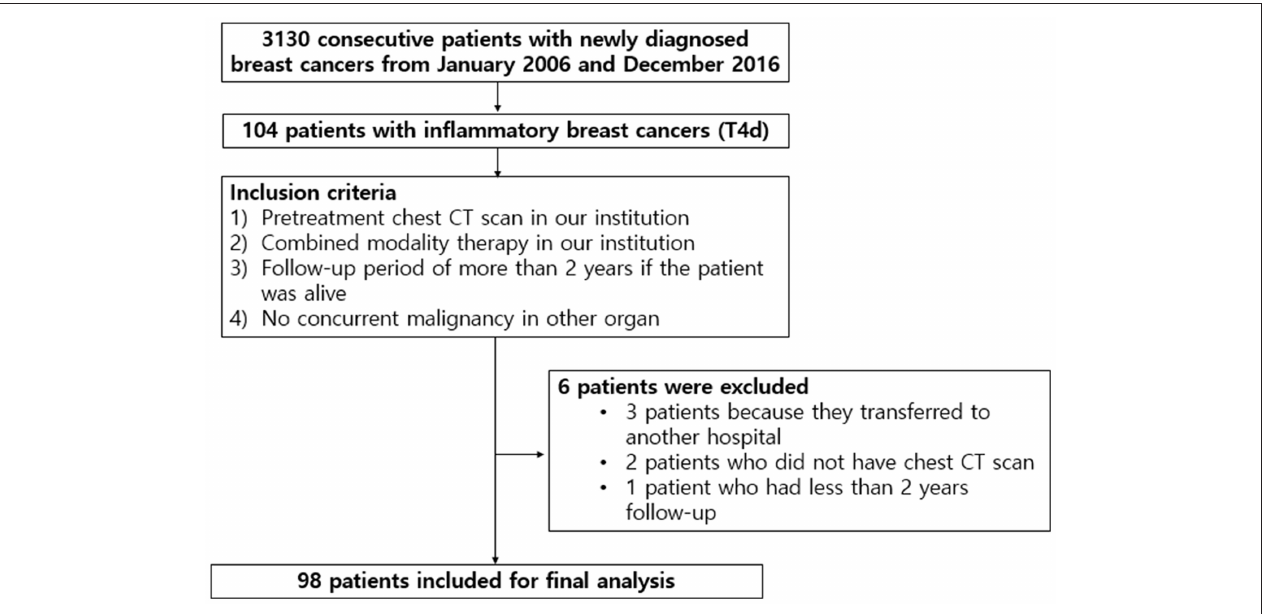
FIGURE 1 | A flow diagram of study